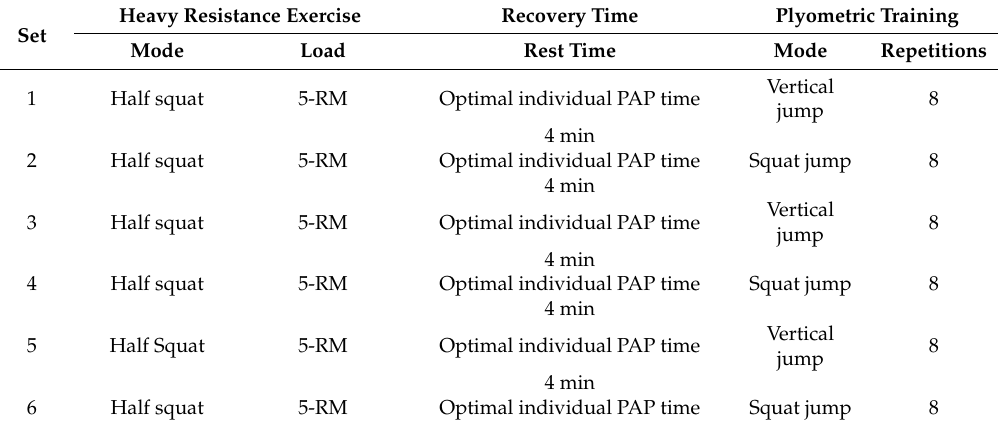
Table 2. Complex training